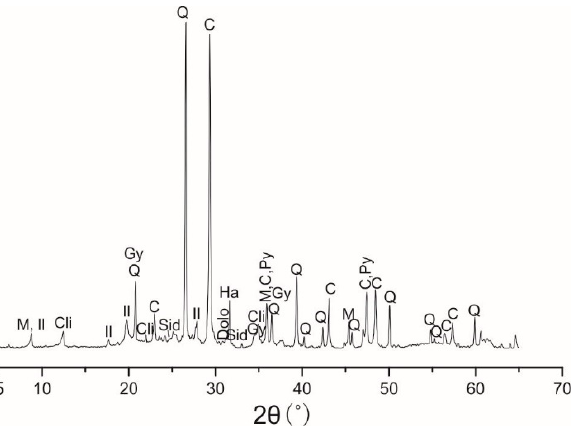
Figure 2. X-ray diffraction diagram of surface sediments in the Xisha Uplift (s9). M: muscovite, Il: illite, Cli: clinopyroxenite, Gy: gypsum, Q: quartz, C: calcite, Sid: siderite, Dolo: dolomite, Ha: halite, Py: pyrite. Table 1. Mineralogical assemblages in bulk sediments of the southwestern Xisha Uplift, South China Sea (SCS). Samples Water Depth